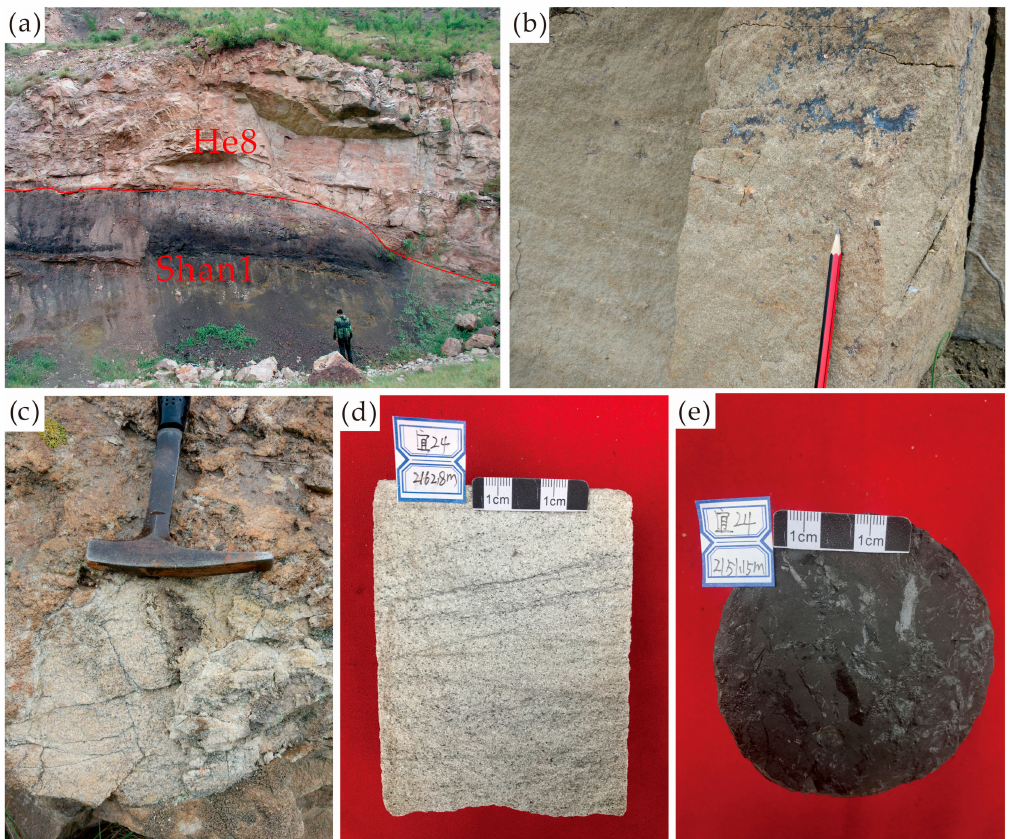
Figure 2. Photographs of the field outcrops and drilling cores in the study area. ( a ) the boundary between the Shan 1 and He 8 Member of the Kouzhen outcrop; ( b ) pebbly medium–coarse grained sandstone of the Hancheng outcrop; ( c ) pebbly coarse grained sandstone of the Kouzhen outcrop; ( d ) tabuler cross bedding in the medium grained sandstone from the drilling cores in Well Yi24; ( e ) the fragments of plant fossils in the grey–black mudstone from the drilling cores in Well